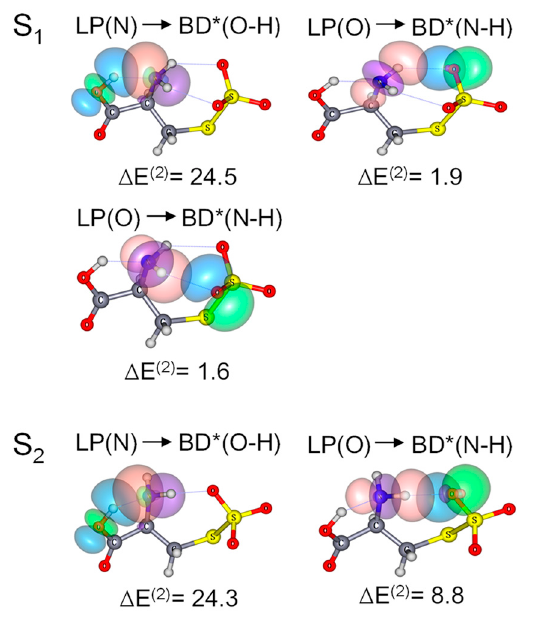
Figure 6. NBO analysis for conformers S 1 and S 2 of [ cysS-SO 3 ] − . (Unit: